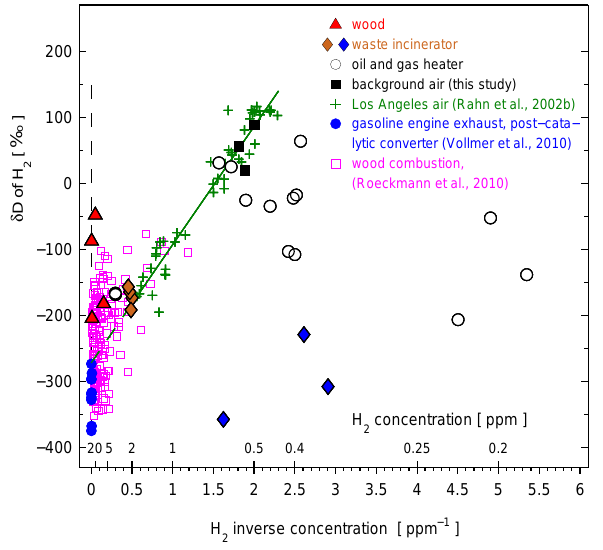
Fig. 3. Relationship of molecular hydrogen (H 2 ) isotopic compo- sition ( δ D) versus inverse H 2 mole fraction (“Keeling plot”) for samples from this study compared with results from Rahn et al. (2002a) with a green line fitted through their data, from Vollmer et al. (2010), and R¨ockmann et al. (2010a). Some of our samples are in fair agreement with the relationship found by Rahn et al. (2002a): these are the poorly-adjusted natural gas combustion burners from one waste incinerator plant (I-2, using natural gas post-filter com- bustion for NO 2 removal, shown as orange diamonds) and one res- idential heater. Most oil and gas heater and the waste incinerator samples I-2 (dark blue diamonds) show an opposite relationship, i.e. decreasing mole fraction for decreasing δ D.